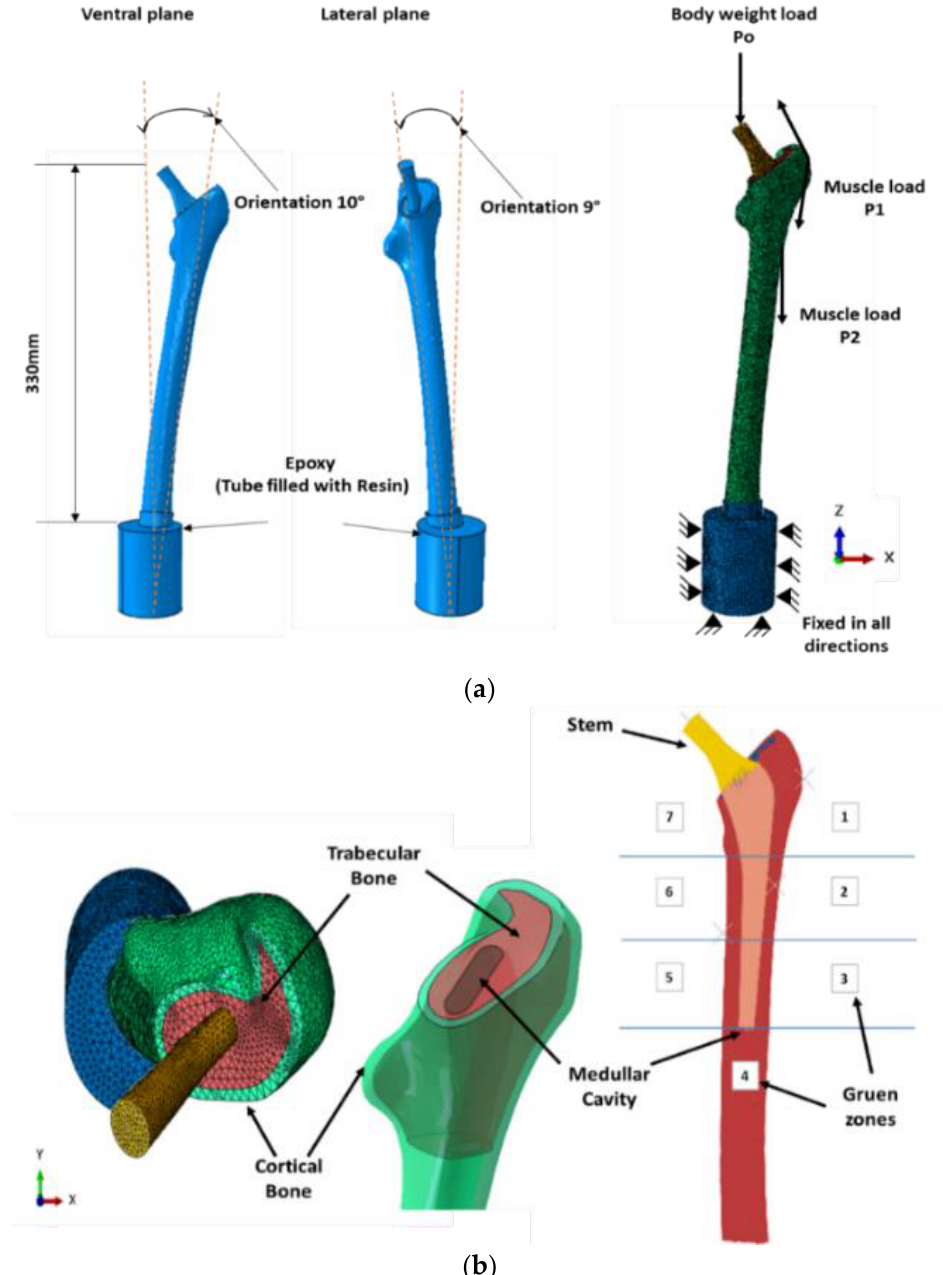
Figure 5. Finite element analysis of stemmed femur: ( a ) complete finite element model with applied physiological loads, ( b ) bone Gruen zones Table 3. Body weight and muscular loads for different walking speeds [39,40] (with reference to Bergmann et al., 1993, Heller et al., 2005).